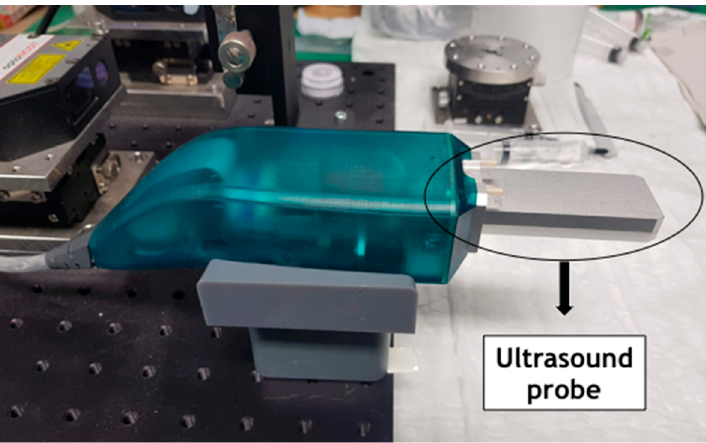
Figure 2. High-frequency intraoral ultrasound scanner used in this study. Prototype showing the ultrasound probe.